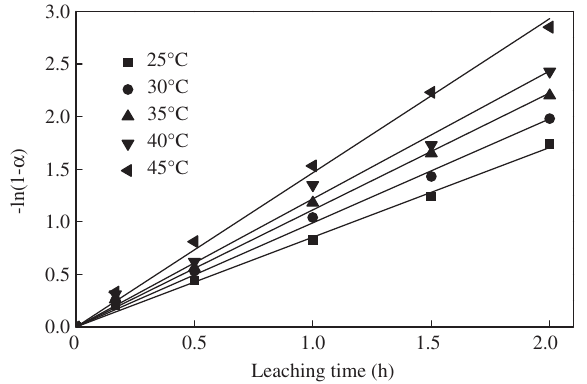
Figure 9: Arrhenius plot for the indium extraction from sphalerite